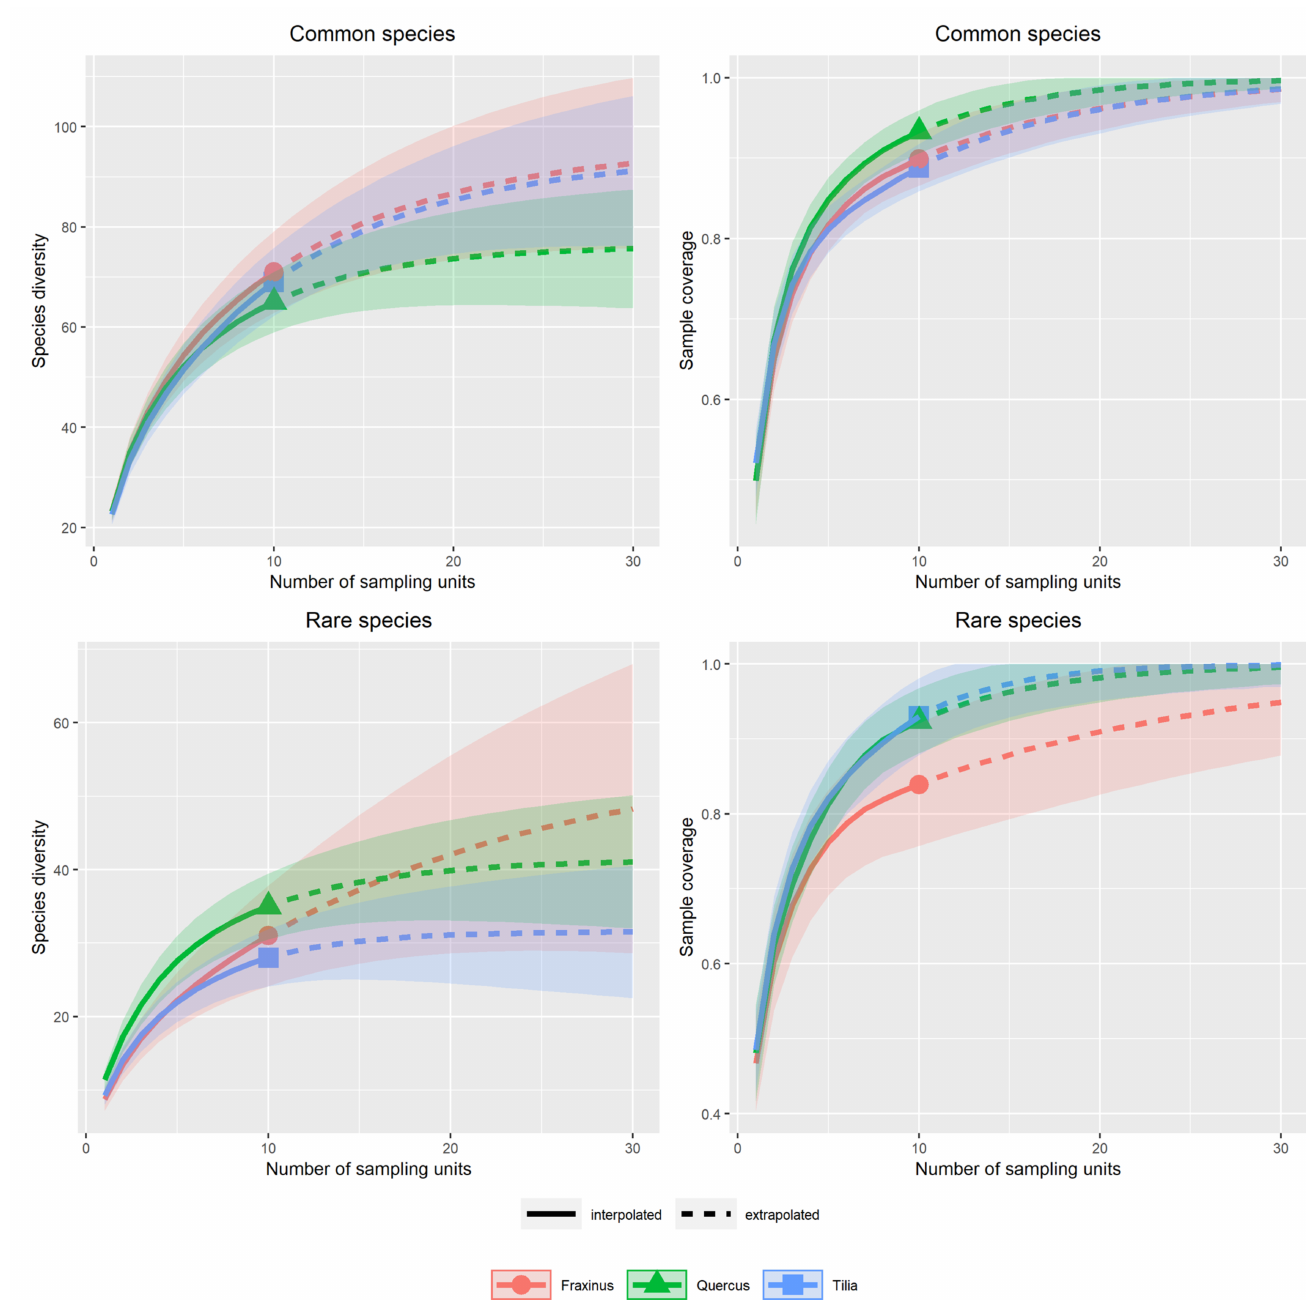
Figure 2. Comparison of species richness and sample coverage among the studied tree species for rare and common beetle species, according to the red list definitions. The left column shows the estimated species richness against the number of traps per tree species. The right column shows the sample coverage against the number of traps per tree species. The bands mark the 95% confidence interval. For the common beetle species, full sample coverage was not reached by our number of sampling units in any tree species. With the extrapolated 30 sampling units, the curves were close to saturation, more so for Q. robur than for the other tree species. For the rare beetle species, a much lower sample coverage was reached in F. excelsior than in the other two tree species (Figure